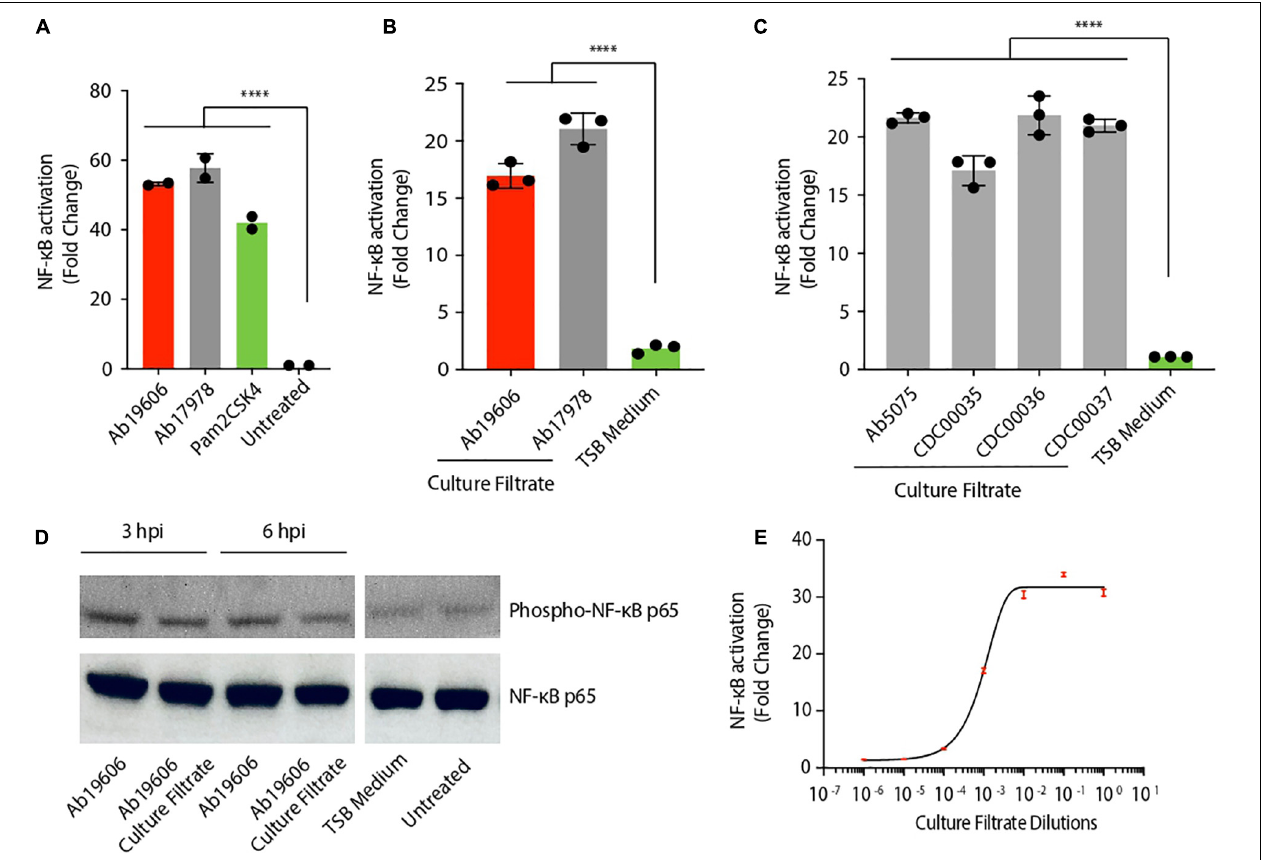
FIGURE 1 | Acinetobacter baumannii secretes pro-inflammatory factors. (A) THP1-XBlue reporter cells infected with A. baumannii (Ab19606 and Ab17978) at MOI 10. Levels of secreted embryonic alkaline phosphatase (SEAP) were assessed after 24 h of infection. The experiments were done in triplicates. Error bars represent standard deviation. One-way ANOVA with Tukey’s multiple comparisons test. (B) THP1-XBlue reporter cells treated with culture filtrates from A. baumannii (Ab19606 and Ab17978). TSB medium was used to grow the bacterial cultures and fresh TSB medium treatment served as the negative control. Levels of SEAP were assessed after 24 h from the beginning of the treatment. The experiments were done in triplicates. Error bars represent standard deviation. One-way ANOVA with Tukey’s multiple comparisons test. (C) THP1-XBlue reporter cells treated with culture filtrates from the indicated clinical isolates of A. baumannii . TSB medium was used to grow the bacterial cultures and fresh TSB medium treatment served as the negative control. Levels of SEAP were assessed after 24 h from the beginning of the treatment. The experiments were done in triplicates. Error bars represent standard deviation. One-way ANOVA with Tukey’s multiple comparisons test. (D) Western blot to check the phosphorylation of NF- κ B p65 in RAW264.7 macrophages after the indicated infection (at MOI 10) or culture filtrate treatment. (E) THP1-XBlue reporter cells treated with different dilutions of the culture filtrate from A. baumannii (Ab19606). 10-fold serial dilutions of the culture filtrate were done in fresh TSB medium. Levels of SEAP were assessed after 24 h from the beginning of the treatment. The experiments were done in triplicates. Error bars represent standard deviation. All the experiments were performed three times independently. * P < 0.05, ** P < 0.01, *** P < 0.001, **** P <